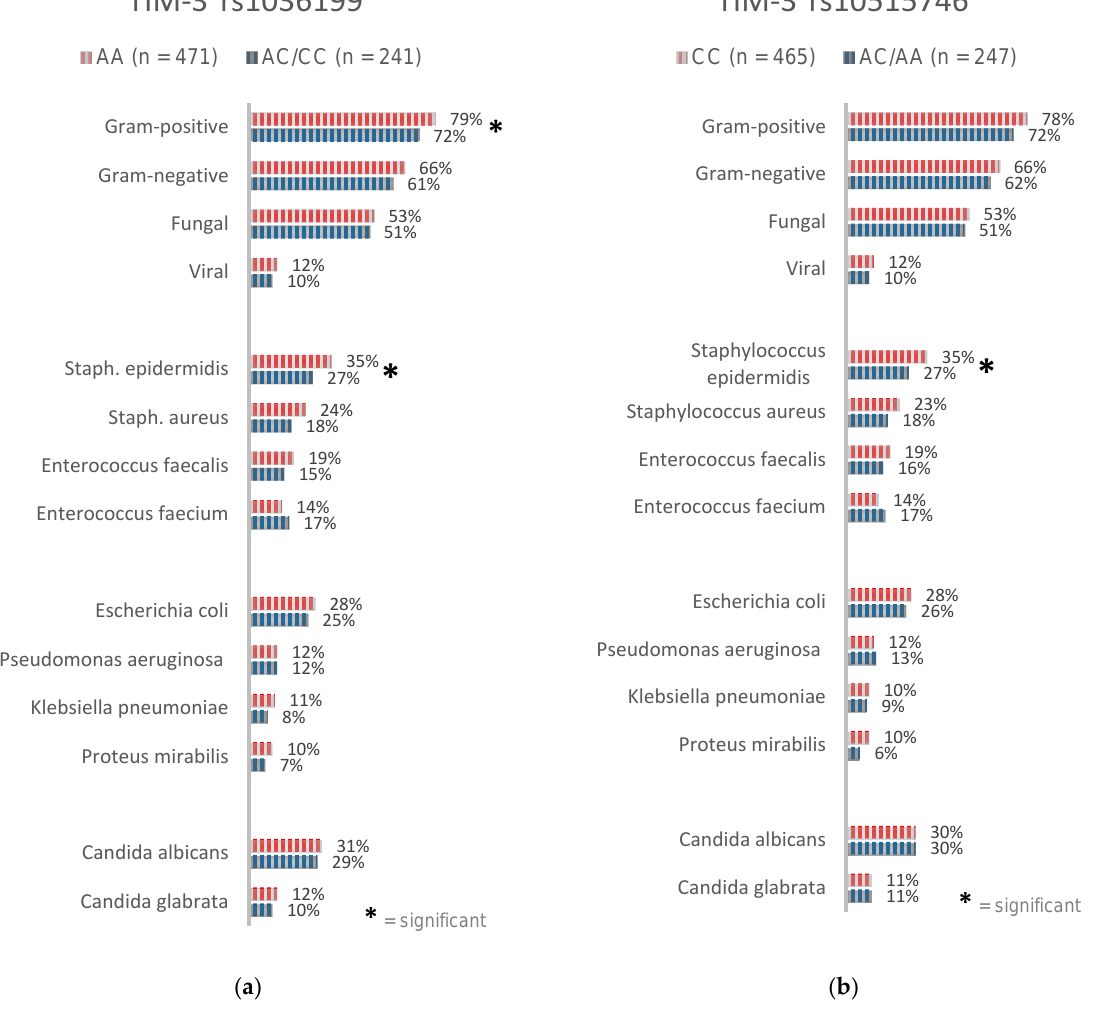
Figure 3. Frequencies of the type of infection and specific pathogens according to ( a ) TIM-3 rs1036199 and ( b ) TIM-3 rs10515746 genotypes.